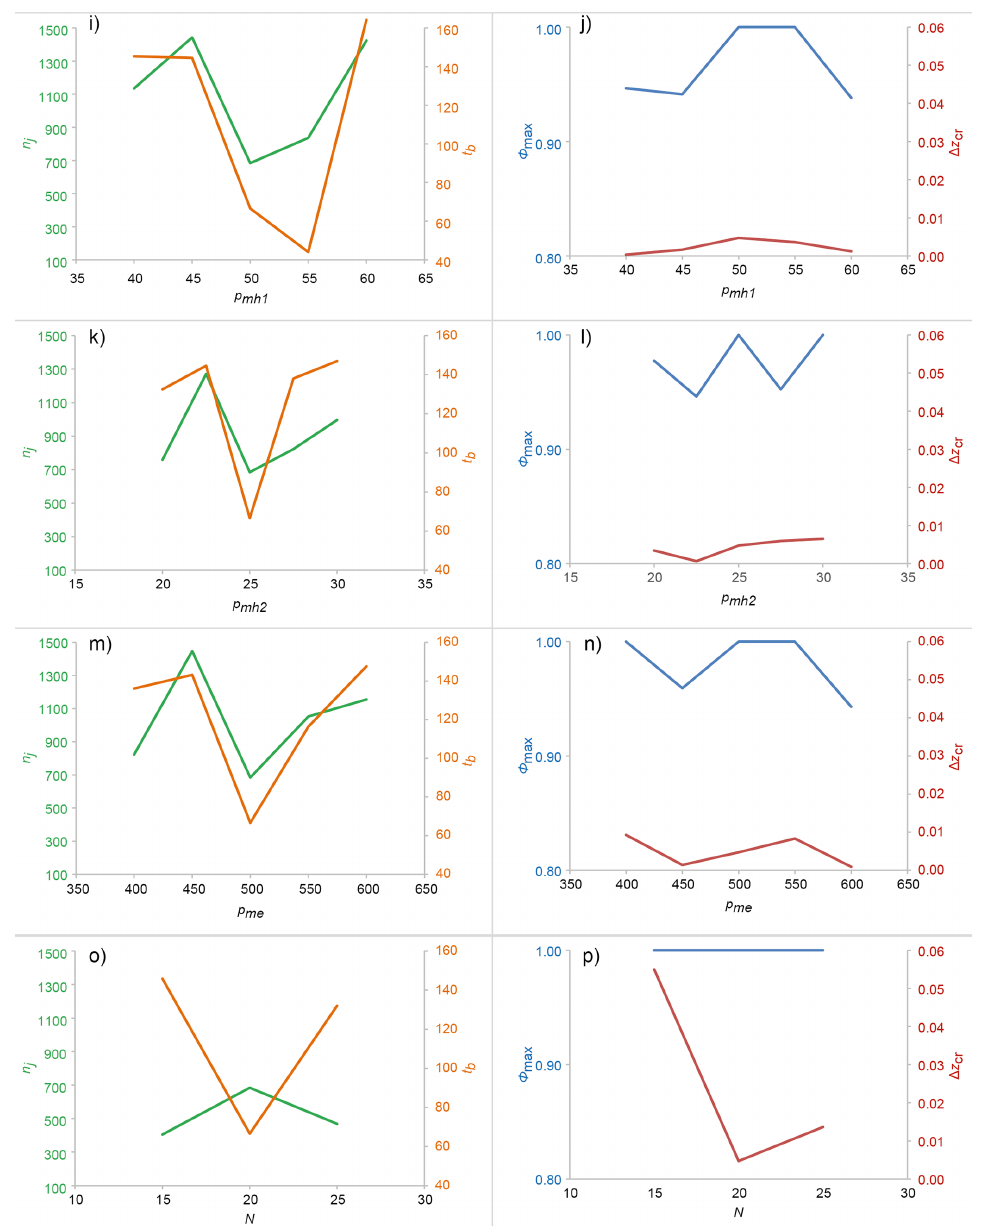
Figure 19. Maximum fitness ( (cid:56) max ) , safety margin ( (cid:49)z cr ) , number ( n i ) of iterations needed to first reach (cid:56) max , and base time ( t b ) of the average kernel, based on GA parameters listed in Table